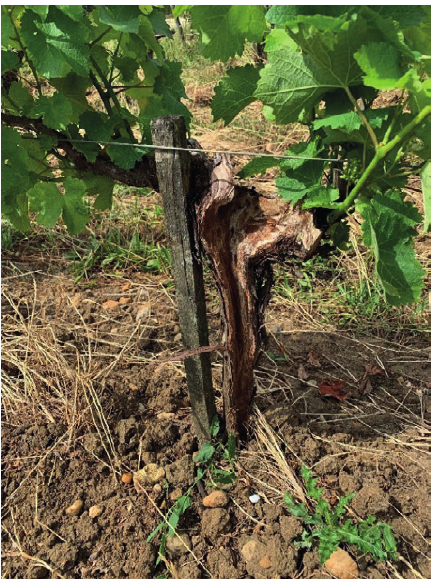
Figure 2. Examples of ‘Sauvignon Blanc’ vines curetted in the Couhins III-7